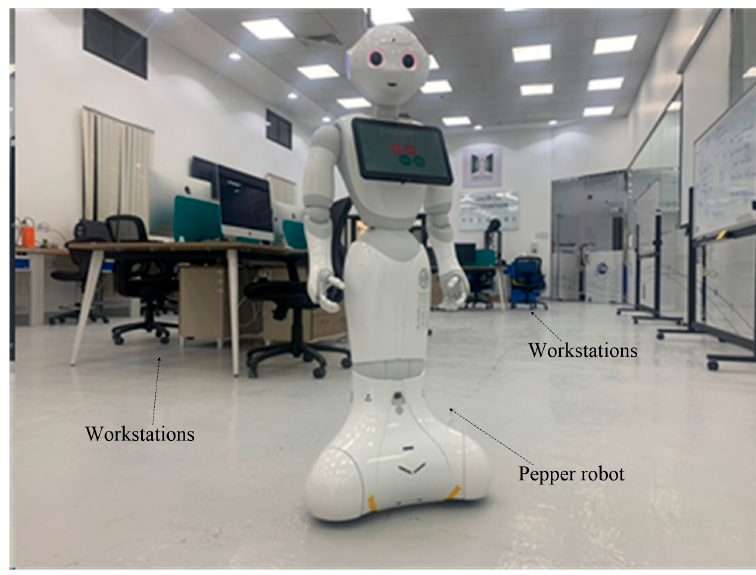
Figure 4. Side view of Area 2 (IIRC Fablab).